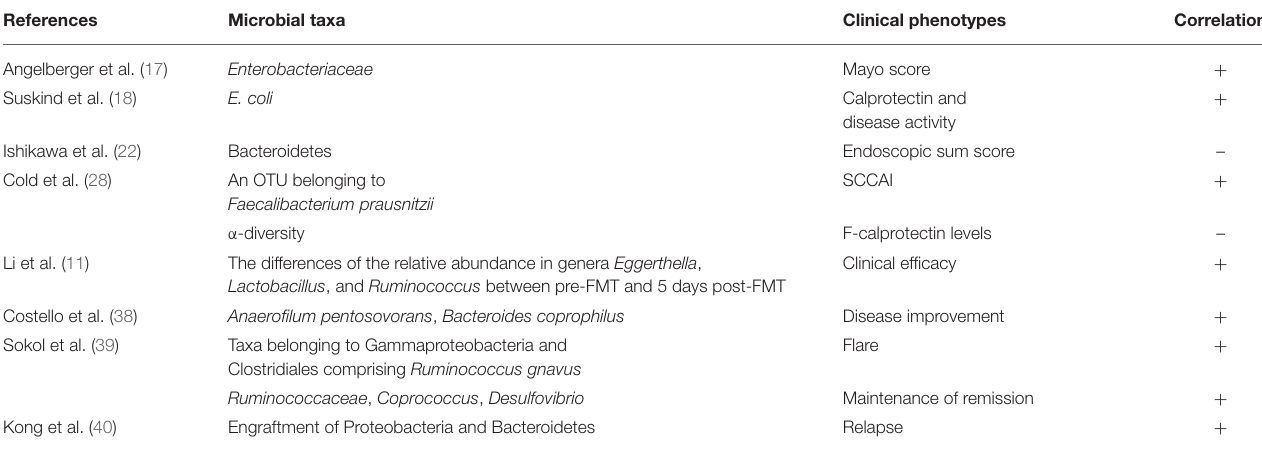
TABLE 5 | Correlation between microbiota and clinical phenotypes.